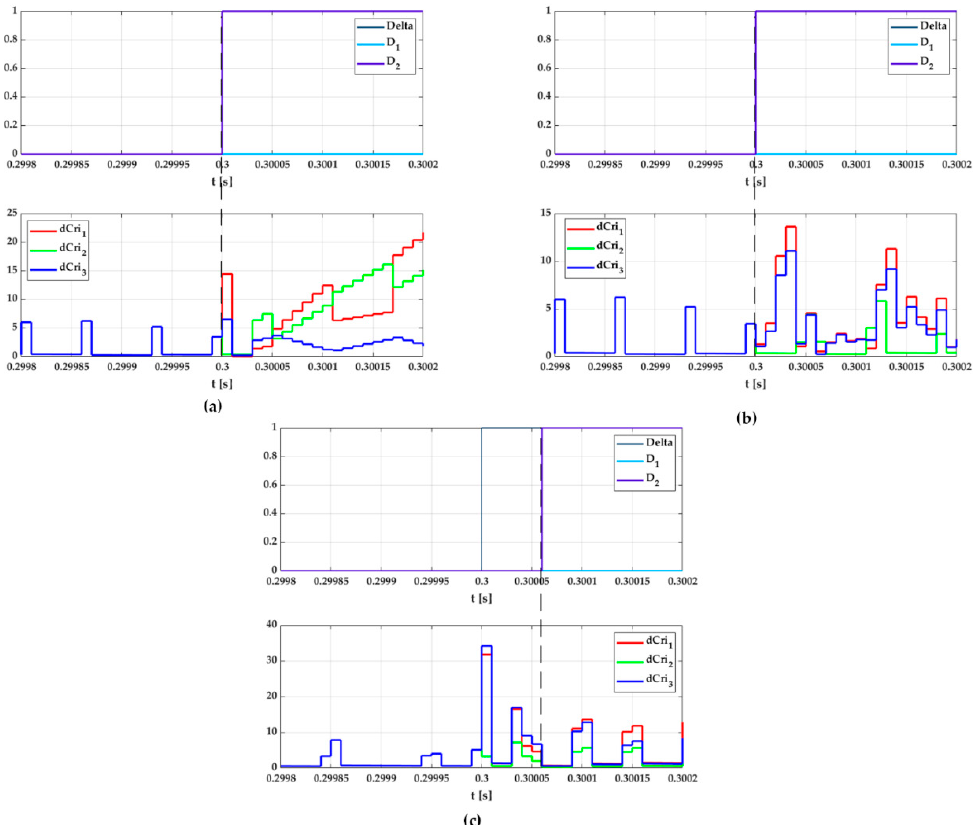
Figure 5. Detector responses and transients of marker errors during lack of signal: ( a ) measurement white Gaussian noise (20 dB); ( b ) variable gain (1.2 i a ) ; ( c ) in phase B in simulation tests.